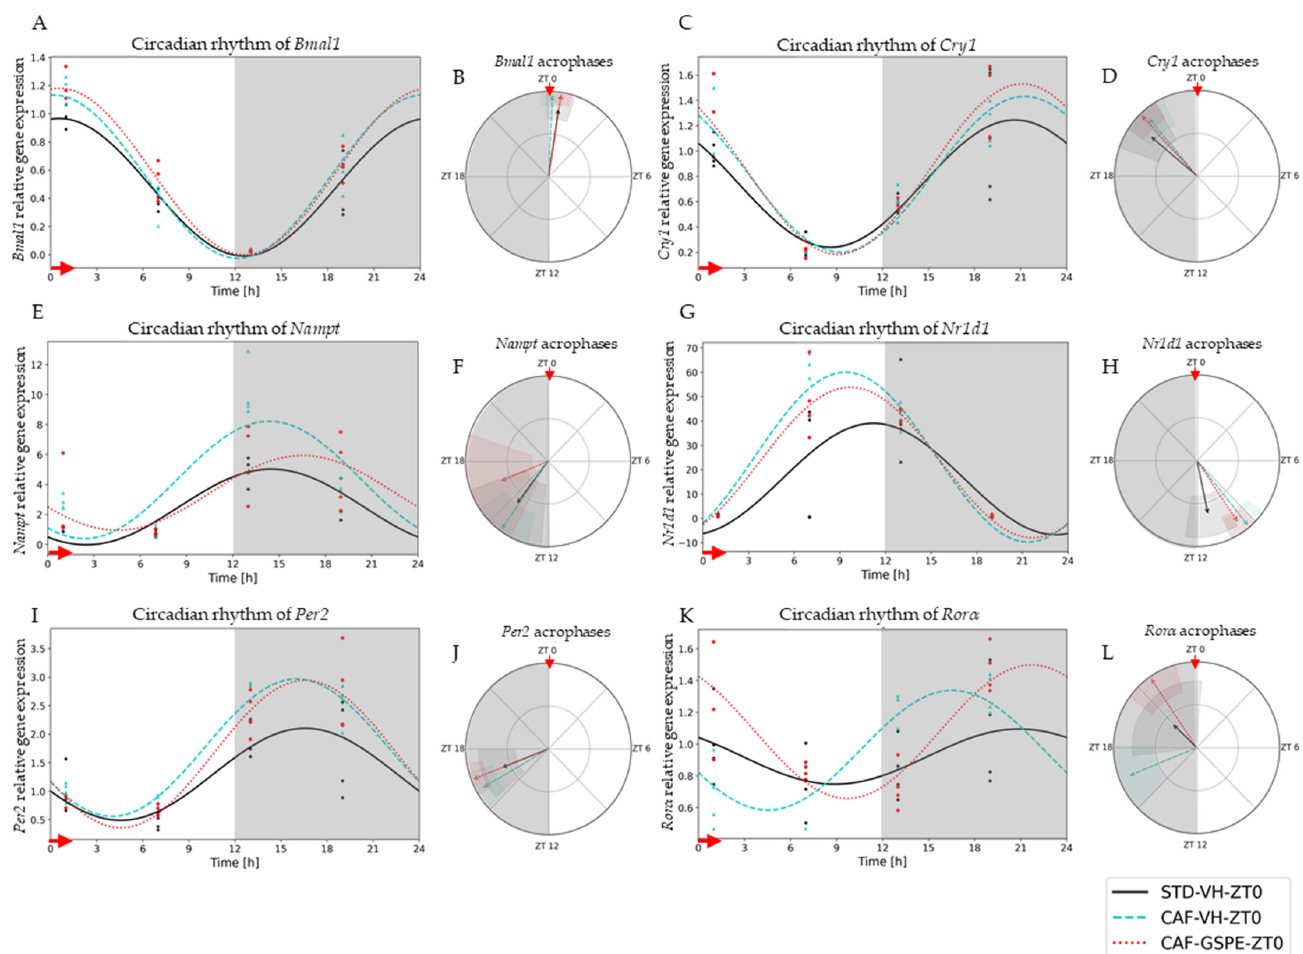
Figure 2. Estimated circadian rhythms (relative gene expression) of groups treated in the morning (ZT0). ( A ) Estimated circadian rhythms and ( B ) acrophases with their amplitudes represented of Bmal1 for ZT0-vehicle and treatments groups (STD-VH, CAF-VH and CAF-GSPE). ( C ) Estimated circadian rhythms and ( D ) acrophases with their amplitudes represented of Cry1 for ZT0-vehicles and treatments groups (STD-VH, CAF-VH and CAF-GSPE). ( E ) Estimated circadian rhythms and ( F ) acrophases with their amplitudes represented of Nampt for ZT0-vehicle and treatments groups (STD-VH, CAF-VH and CAF-GSPE). ( G ) Estimated circadian rhythms and ( H ) acrophases with their amplitudes represented of Nr1d1 for ZT0-vehicle and treatments groups (STD-VH, CAF-VH and CAF-GSPE). ( I ) Estimated circadian rhythms and ( J ) acrophases with their amplitudes represented of Per2 for ZT0-vehicle and treatments groups (STD-VH, CAF-VH and CAF-GSPE). ( K ) Estimated circadian rhythms and ( L ) acrophases with their amplitudes represented of Ror α for ZT0-vehicles and treatments groups (STD-VH, CAF-VH and